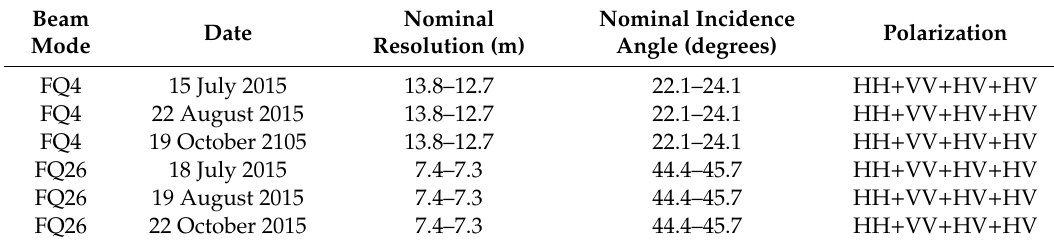
Table 1. Description of the RADARSAT-2 images used in this